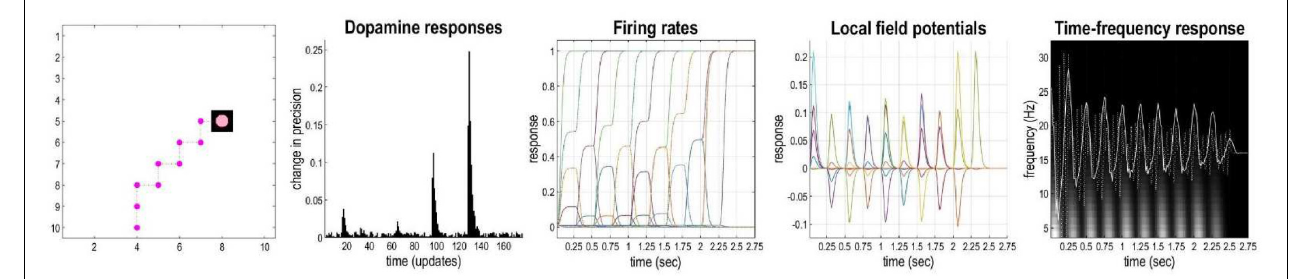
FIGURE 4 | Simulated electrophysiological responses for a representative sequence of moves. The left panel shows the agent’s trajectory, followed by (synthetic) dopamine responses, firing rates, local field potentials and time-frequency responses. Please see main text for more